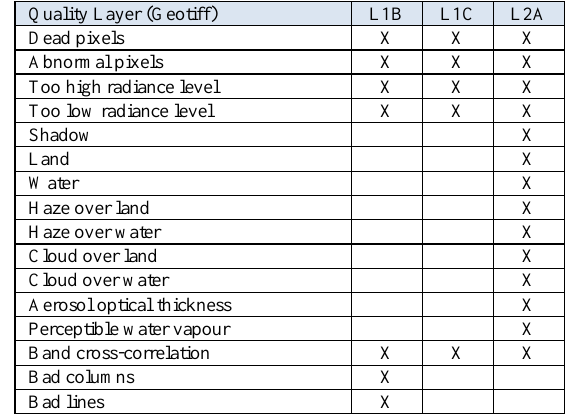
Table 3 Quality layers attached to the